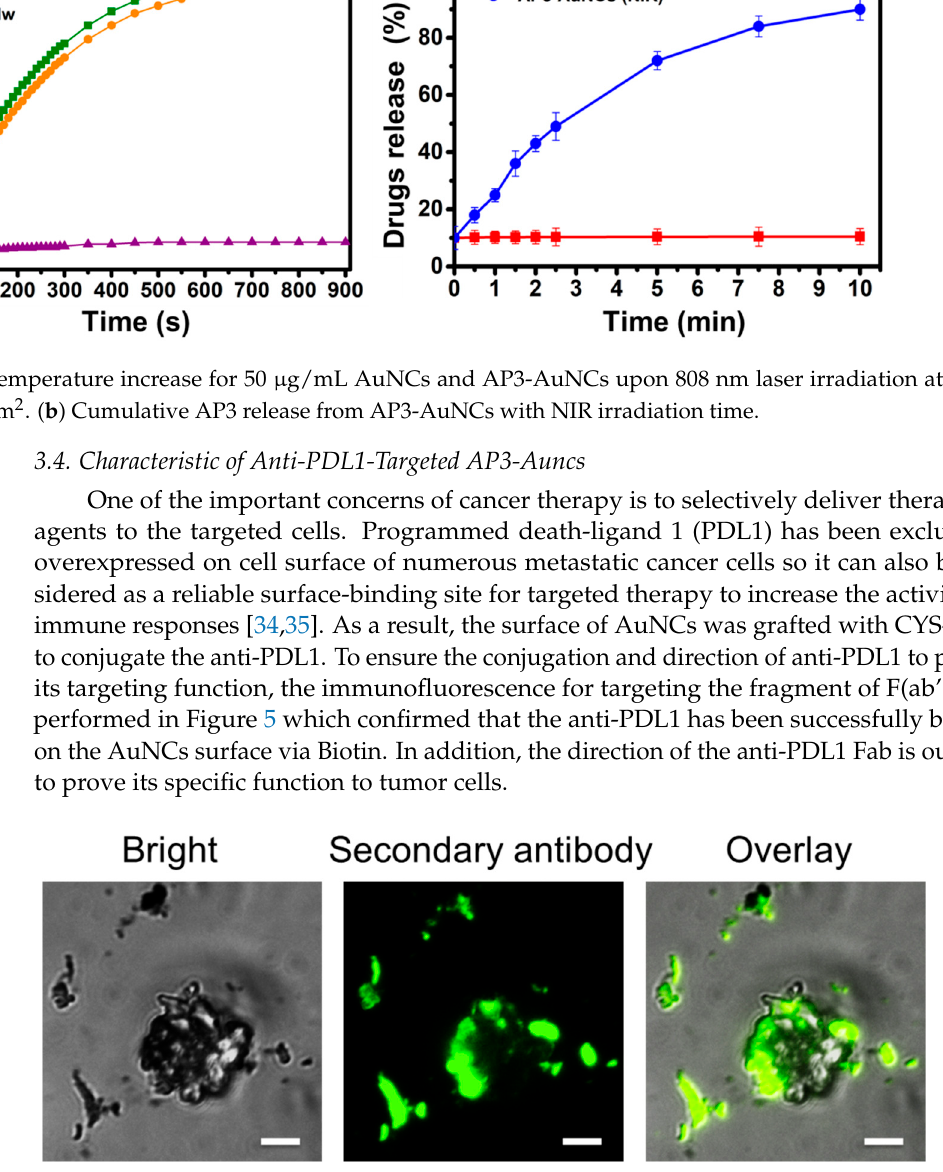
Figure 6. The cell association evaluation of ( a ) non-targeted RhoB-labeled AP3-AuNCs and ( b ) RhoB-labeled AP3-AuNCs-anti-PDL1 with 1 h and 4 h incubation using fluorescent staining. The f-actin, the nucleus of cells, and the RhoB-labeled AP3-AuNCs/RhoB-labeled AP3-AuNCs -anti-PDL1 were labeled as green, blue, and red colors, respectively (Scale bar = 10 μ m).